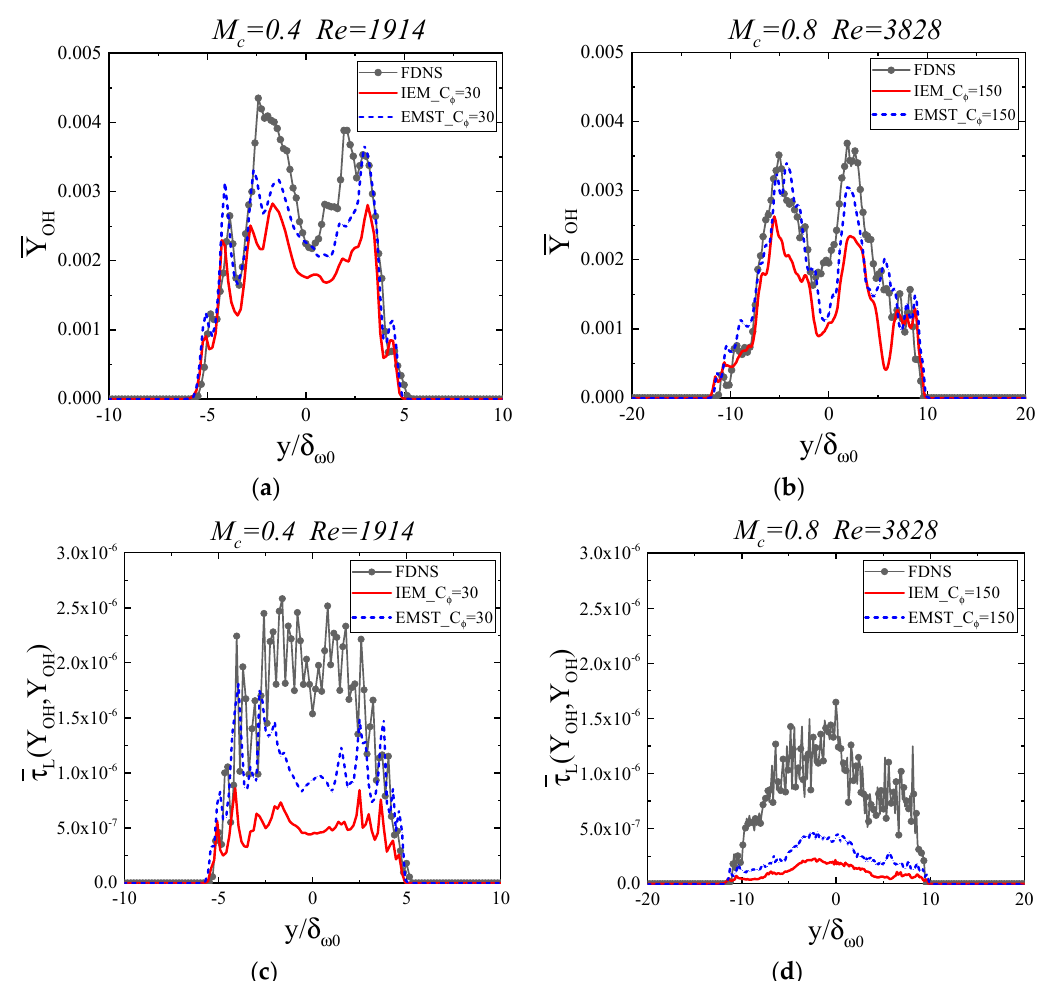
Figure 13. Cross-stream variation of some of the Reynolds-averaged moments obtained using DNS, IEM, and EMST: ( a ) the OH mass fraction distribution for M c = 0.4 case, ( b ) the OH mass fraction distribution for M c = 0.8 case, ( c ) the SGS second moments of the filtered OH mass fraction for M c = 0.4 case, ( d ) the SGS second moments of the filtered OH mass fraction for M c = 0.8 case.